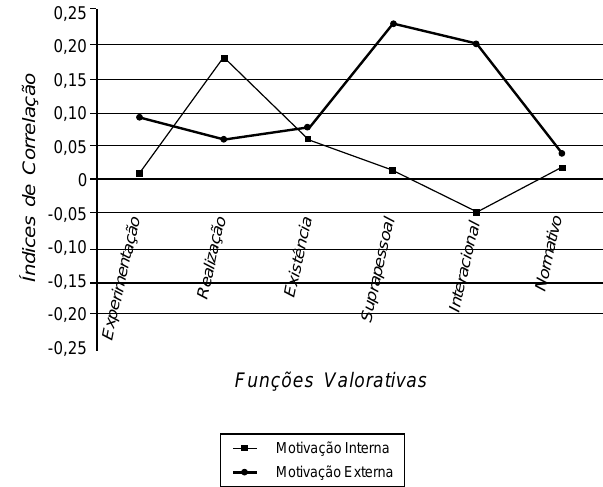
Figura 1 . Representação gráfica das correlações entre as Motivações para Responder sem Preconceito ( Interna vs. Externa ) e as Funções Psicossociais dos